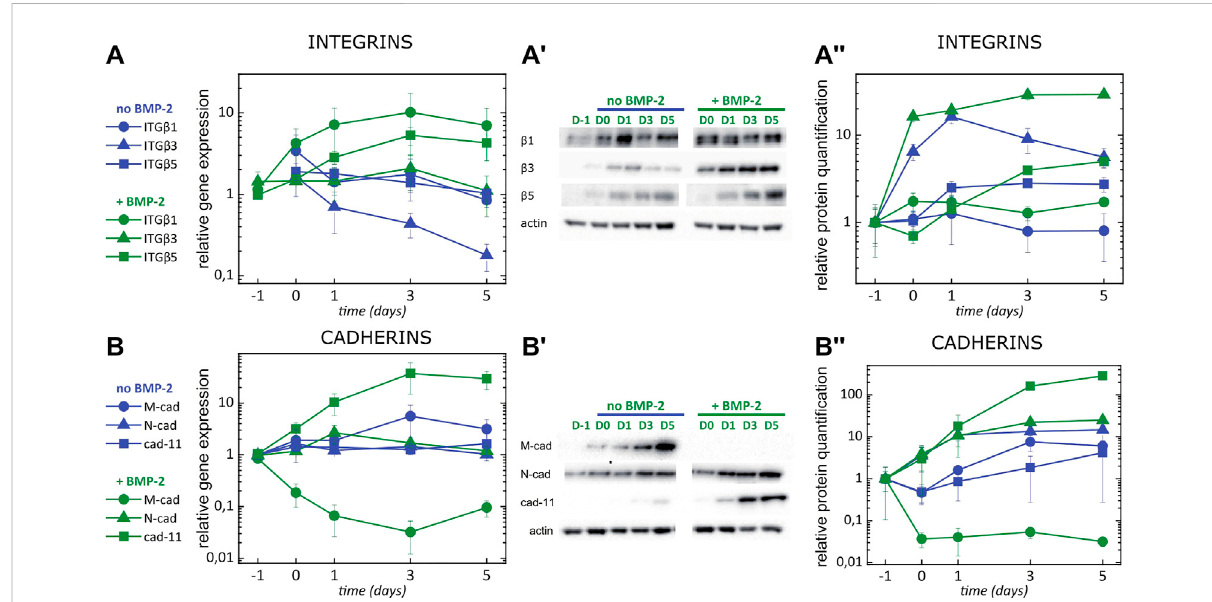
FIGURE 4 bBMP-2 and sBMP-2 induce the expression switch towards speci fi c integrins and cadherin 11 in C2C12 cells. Kinetics of gene expression of (A) ITGB chains (B) cadherins quanti fi ed by RT-qPCR for cells cultured on TCPS without (blue) or with (green) sBMP-2 in solution. (A 9 ,B 9 ) Western blots and (A'',B'') corresponding analysis of kinetics of protein expression. Actin was taken as control for intensity normalization. Data are mean ± SD of three independent